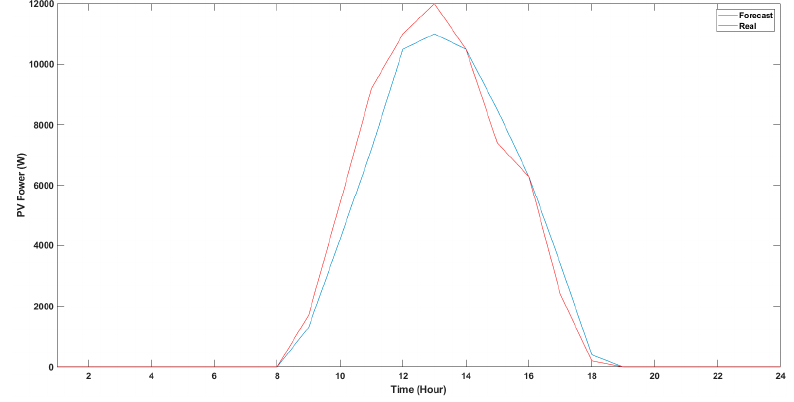
Figure 11. Forecasting and real temperature curves for 04/02/2019. Table 9. Statistical performance measures for temperature.